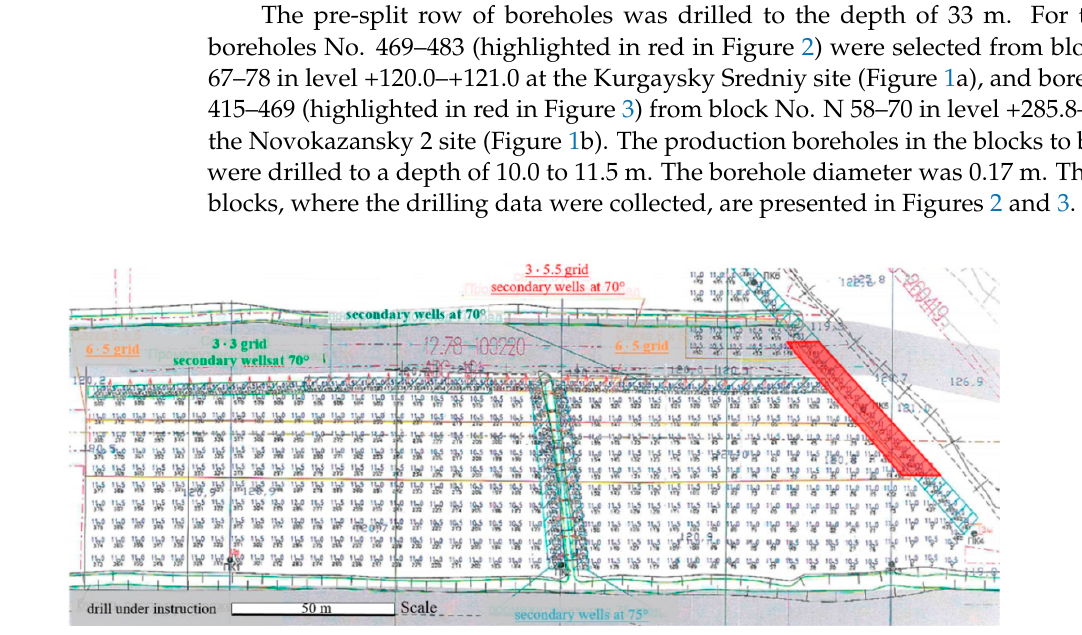
Figure 2. Arrangement of the studied boreholes No. 469–483 in the pre-split row (highlighted in red) of block No. K 67–78 in level +120.0–+121.0 at Kyrgaysky Sredniy site.